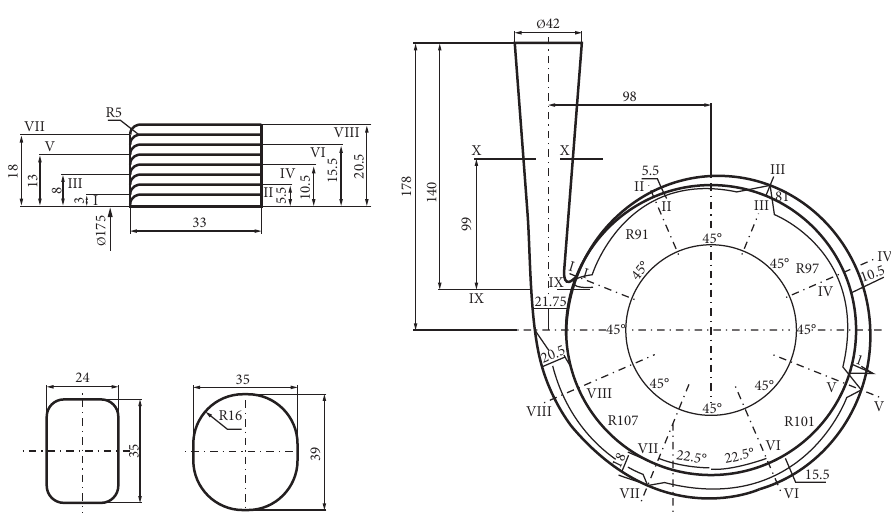
Figure 2: Two-dimensional design drawing of the volute.